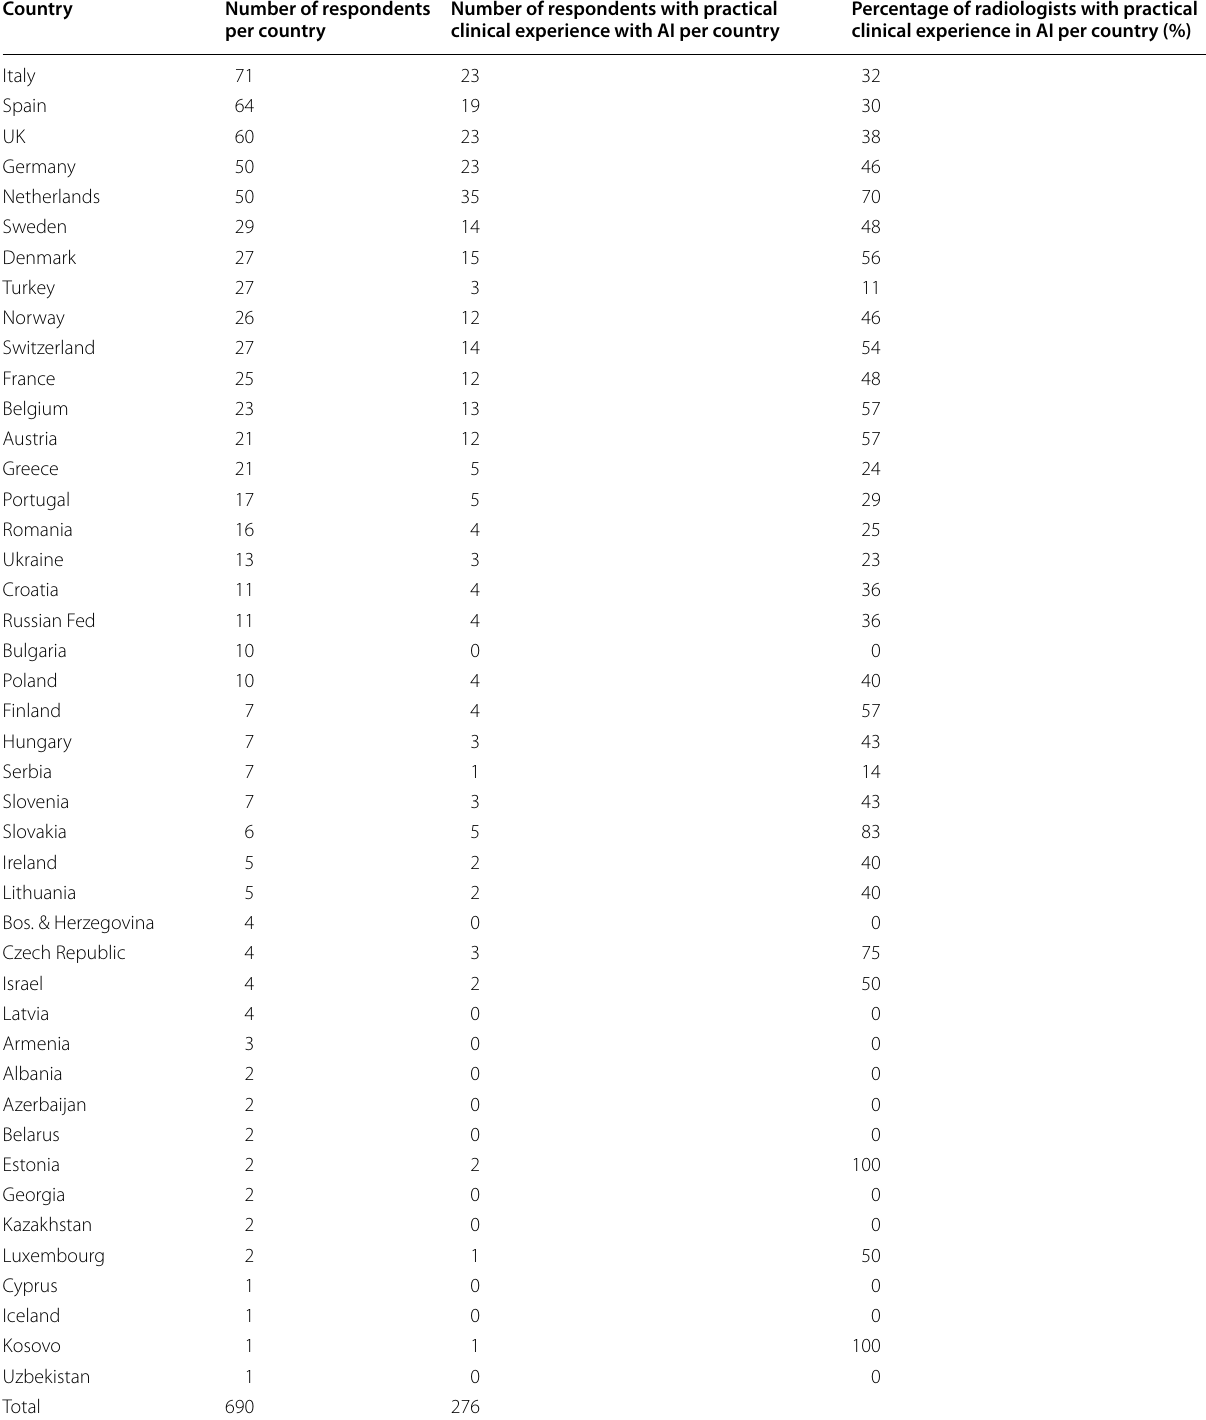
Table 1 Distribution of all 690 respondents by countries and proportion of radiologists with practical clinical experience with AI